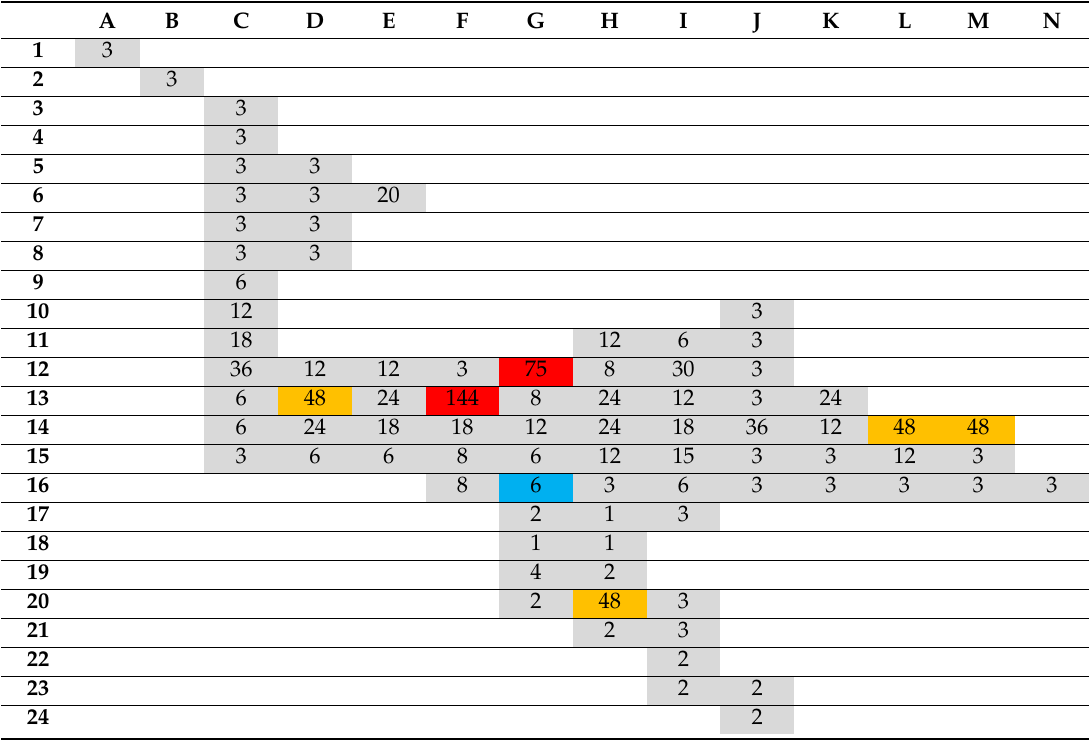
Table 6. Values of ranking index W calculated for particular subareas. The location of the pumping station was marked in blue. The red color indicates the subareas with the highest value of index W . The yellow color indicates the subareas with the next and equal value of this index.